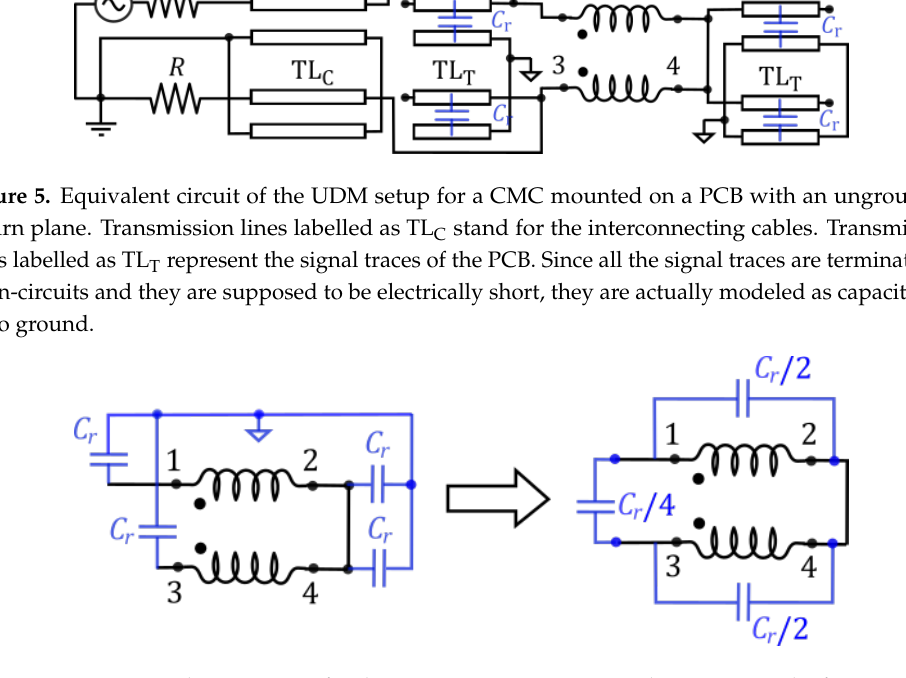
Figure 6. Star to triangle conversion for the parasitic capacitances C r that appear at the four terminals of the CMC in the circuit of Figure